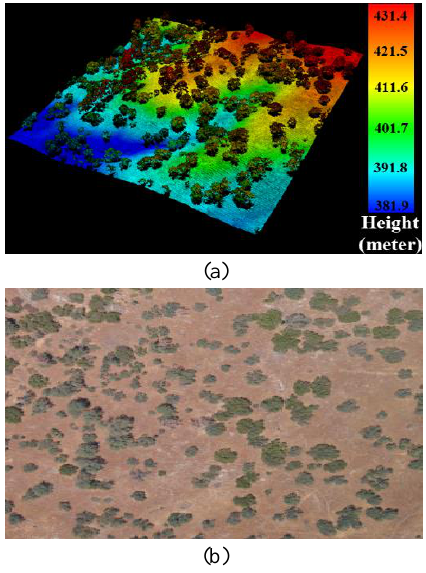
Figure 1. (a) First return point cloud (the legend shows points altitude from the sea level) and (b) aerial image of the study area.